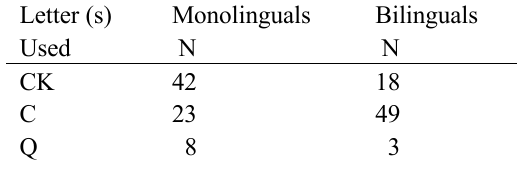
Table 18. Misspellings for the phoneme / k / in dake Letter